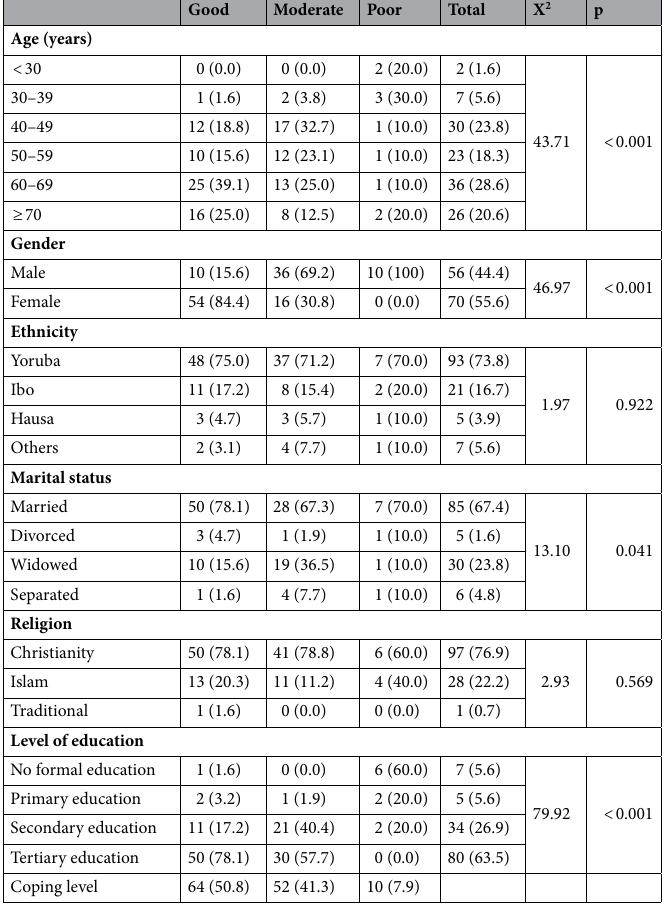
Table 4. Relationship between socio-demographic characteristics and coping strategies of diabetes